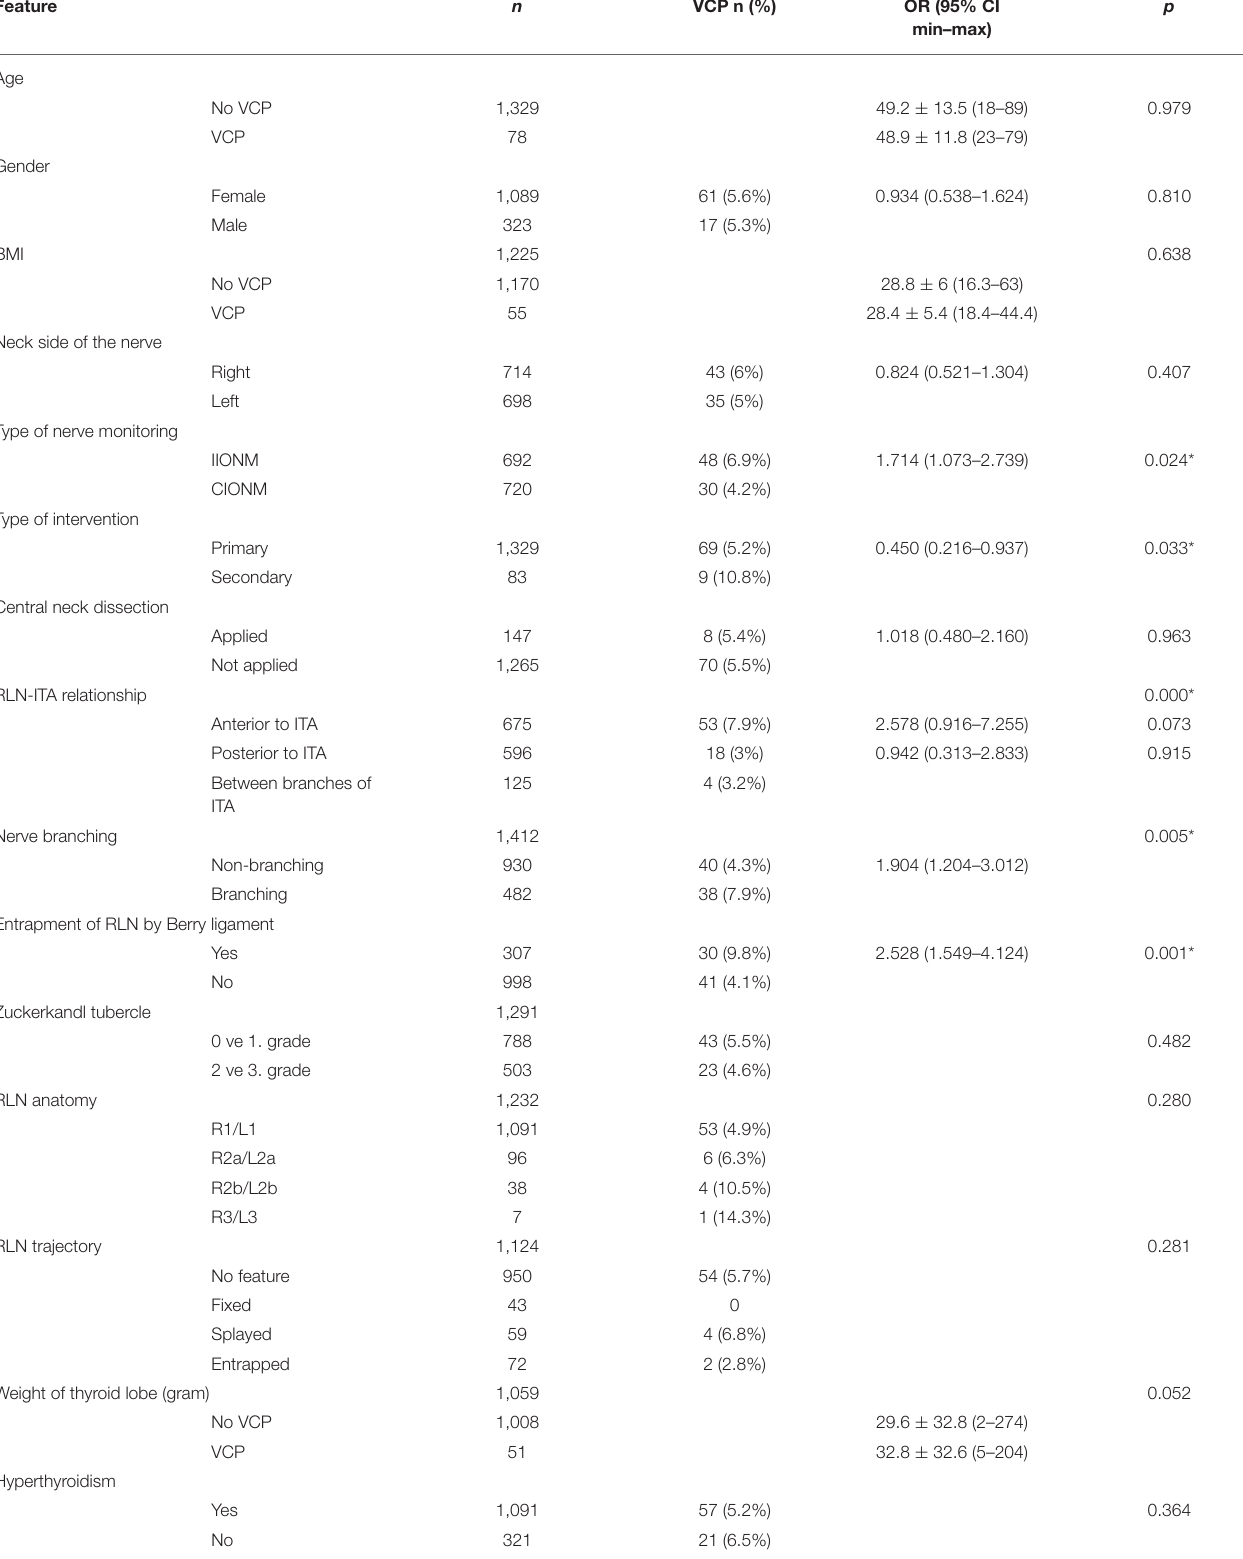
TABLE 2 | Evaluation of clinical and anatomical factors for temporary VCP by univariant